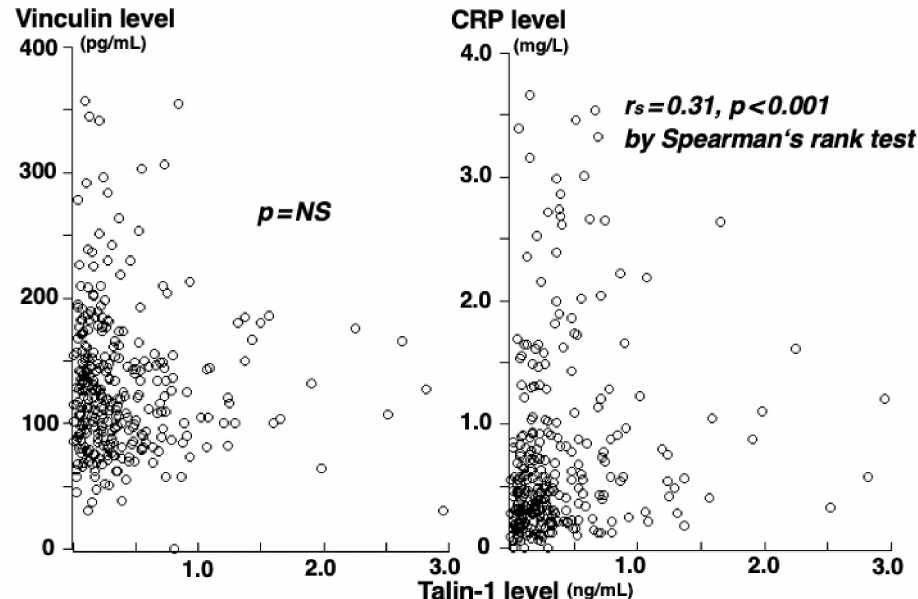
Figure 4. Correlations of plasma talin-1 concentrations with vinculin or CRP concentrations. No correlation was found between vinculin and talin-1 concentrations (rs = − 0.06, p = 0.308) ( left ). However, talin-1 concentrations correlated with CRP concentrations (rs = 0.31, p < 0.001) ( right